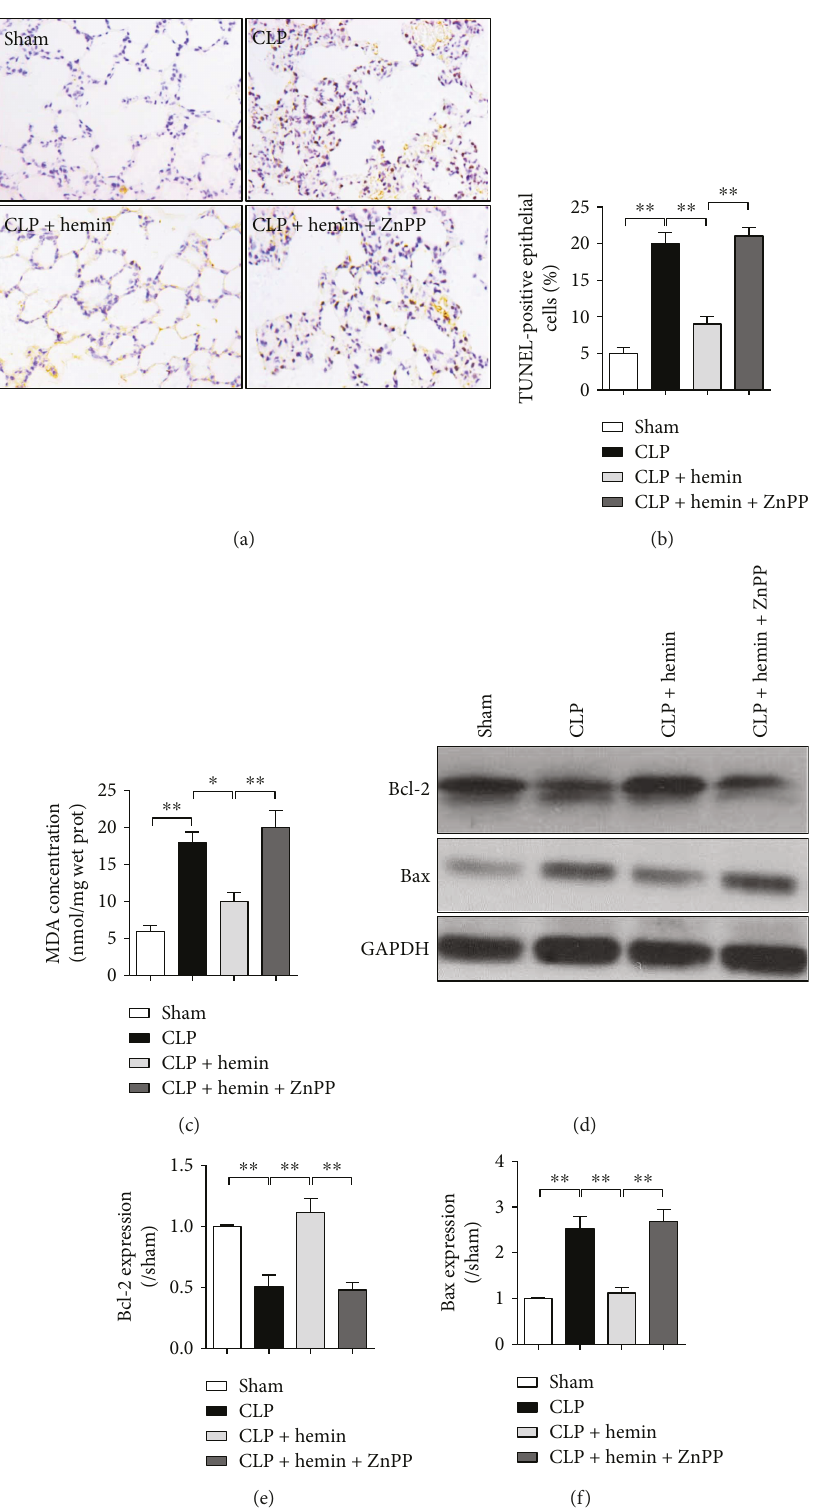
Figure 4: The protective e ff ects of HO-1 activation and inhibition of ER stress were associated with lung cell apoptosis reduction. Sprague- Dawley rats were intraperitoneally injected with saline, hemin (30 mg/kg) 24 h before operation with or without ZnPP (20 mg/kg) 12 h after hemin was given, then received celioectomy with or without CLP surgery. Lung cell apoptosis was detected by using terminal deoxynucleotidyl transferase-mediated nick end labeling (TUNEL) method (a), and TUNEL-positive lung cells were counted (b). (c) Level of MDA concentration in lung tissue. (d – f) Levels of Bcl-2 and Bax were detected using Western blot method, and gray analysis were performed according to the bands. Data are shown as mean ± SEM ( n = 6 ). ∗ P < 0 05 and ∗∗ P < 0 01 ; one-way ANOVA Tukey ’ s post hoc